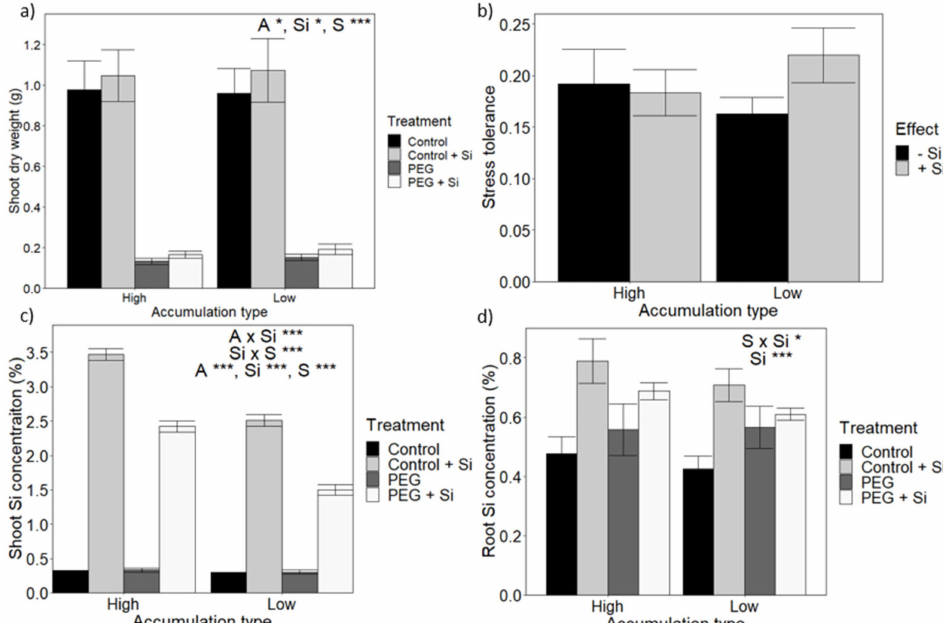
Figure 2. The impact of Si fertilisation on wheat osmotic stress tolerance according to Si accumulation type. ( a ) Shoot dry weight (DW). ( b ) Growth data were normalised to express ‘Stress tolerance’, defined as the ratio between shoot growth under osmotic stress compared to the control. ( c ) Shoot Si concentration. ( d ) Root Si concentration. Statistically significant impacts and interactions, determined by 3-way ANOVA, are indicated in each panel, where *** p < 0.001, ** p < 0.01 and * p < 0.05. Mean values ± SE are shown. N = 4. L: Landrace, A: accumulation type, Si: level of Si fertilisation, S: osmotic stress